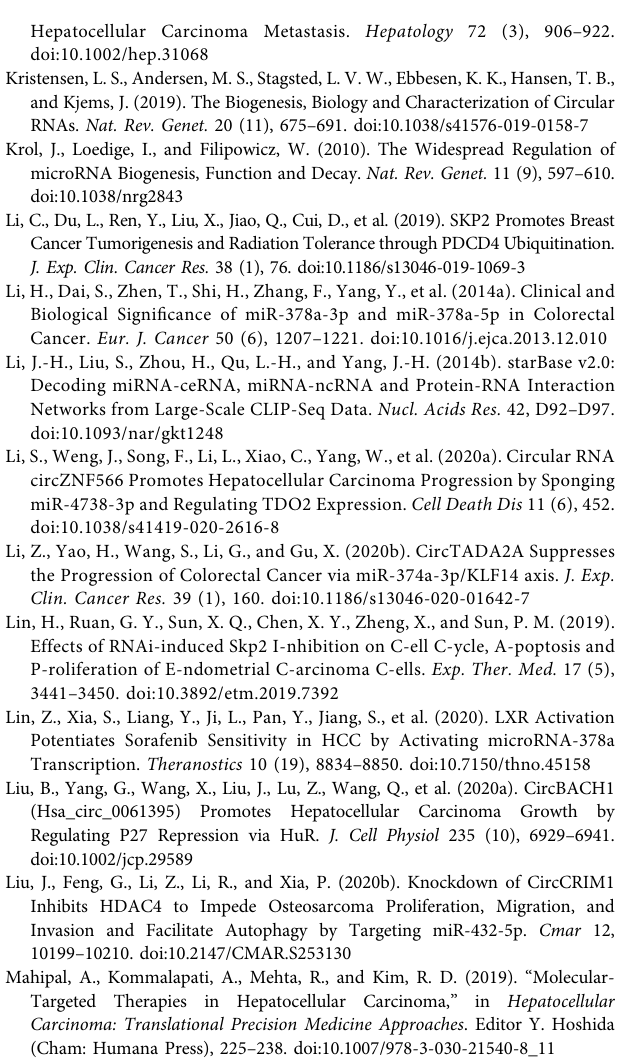
Supplementary Figure S3 | CircCRIM1 promotes HCC proliferation and angiogenesis via the miR-378a- 3p/SKP2 axis. Supplementary Table S1 | Primers for qRT-PCR used in this study. Supplementary Table S2 | Antibodies used in this